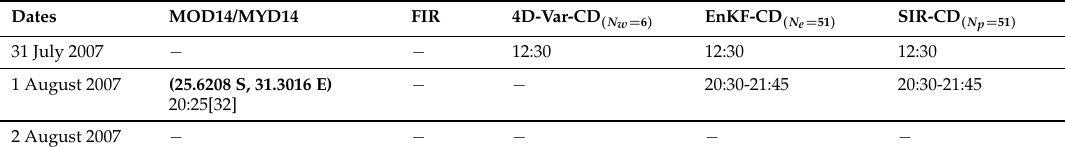
Table 7. Table corresponds to results in Figure